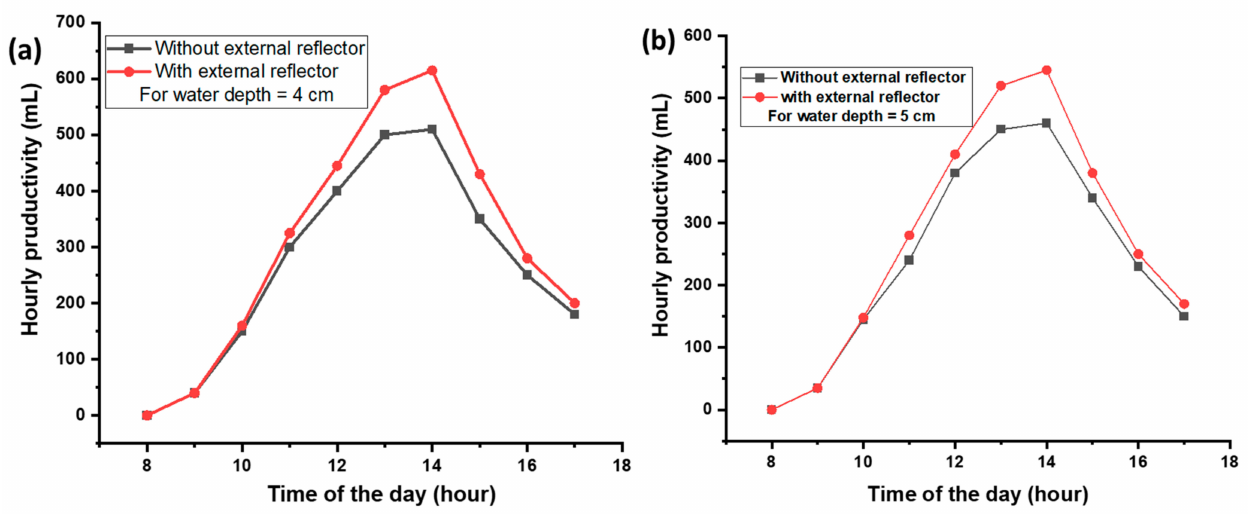
Figure 7. Hourly productivity observations with time (hour) for Case 1 ( a ) and for Case 2 ( b ) with and without an external